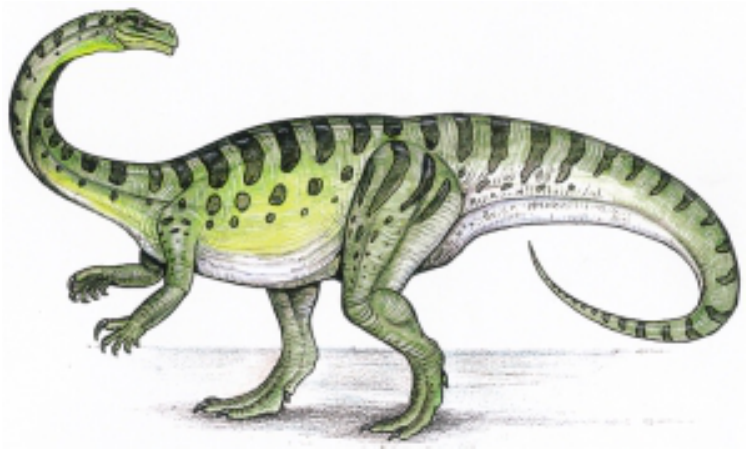
Fig. 9 – Reconstruction of a prosauropod. This group of dinosaurs was recently found in Triassic strata of Rio Grande do